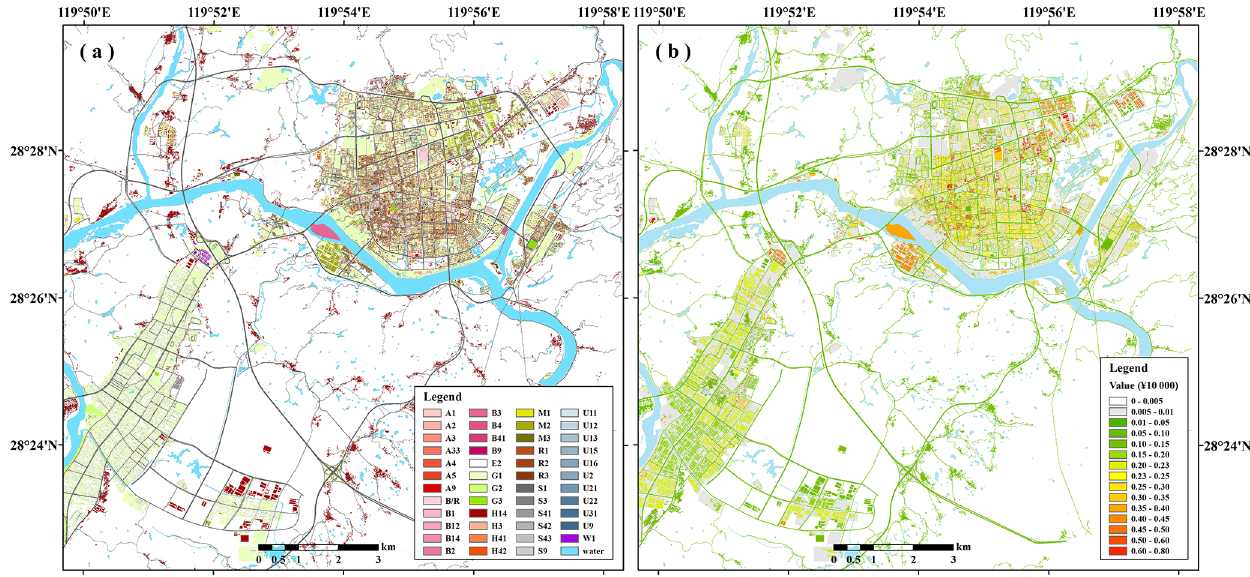
Figure 5. Distribution of land use types (a) and land use values (b) in the central urban area of Liandu district in